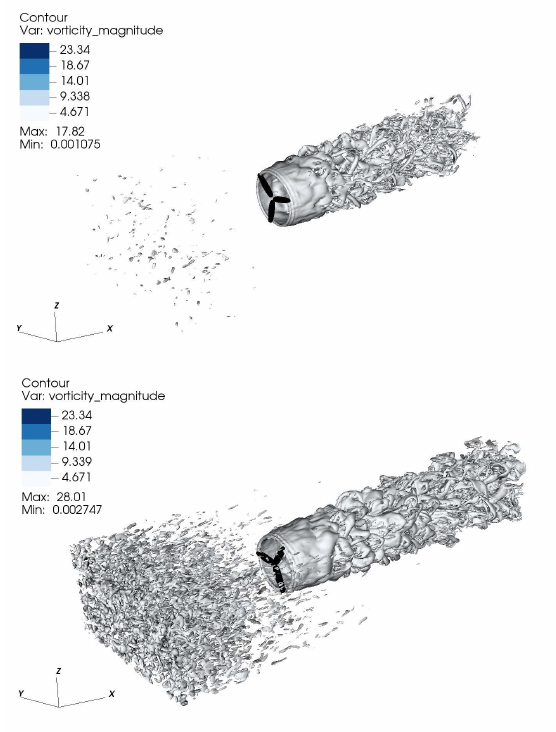
Figure 7. CFD Vorticity magnitude for ( top ) Uo = 0.6 m/s and ( bottom ) Uo = 1.0